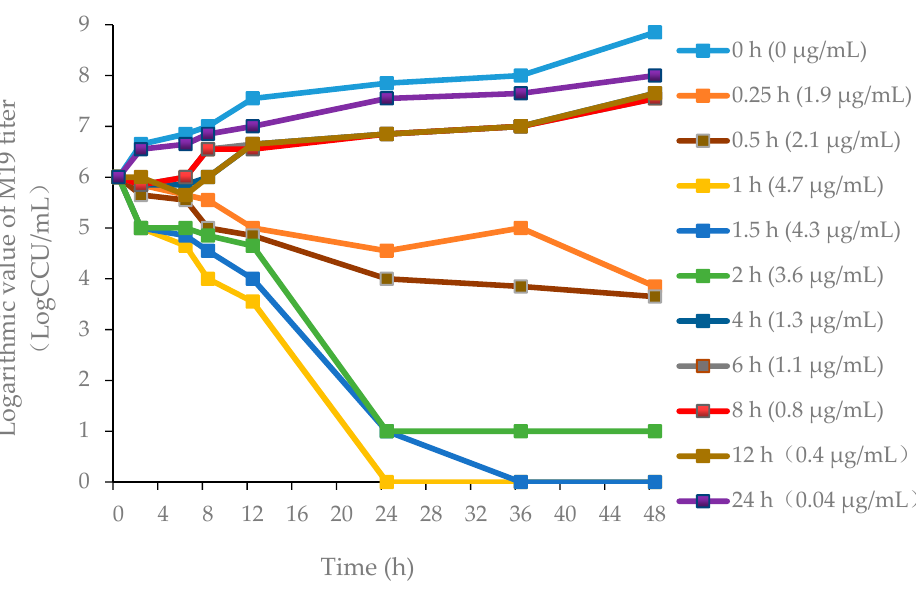
Figure 3. Ex vivo killing-time curves in infected lung tissue.